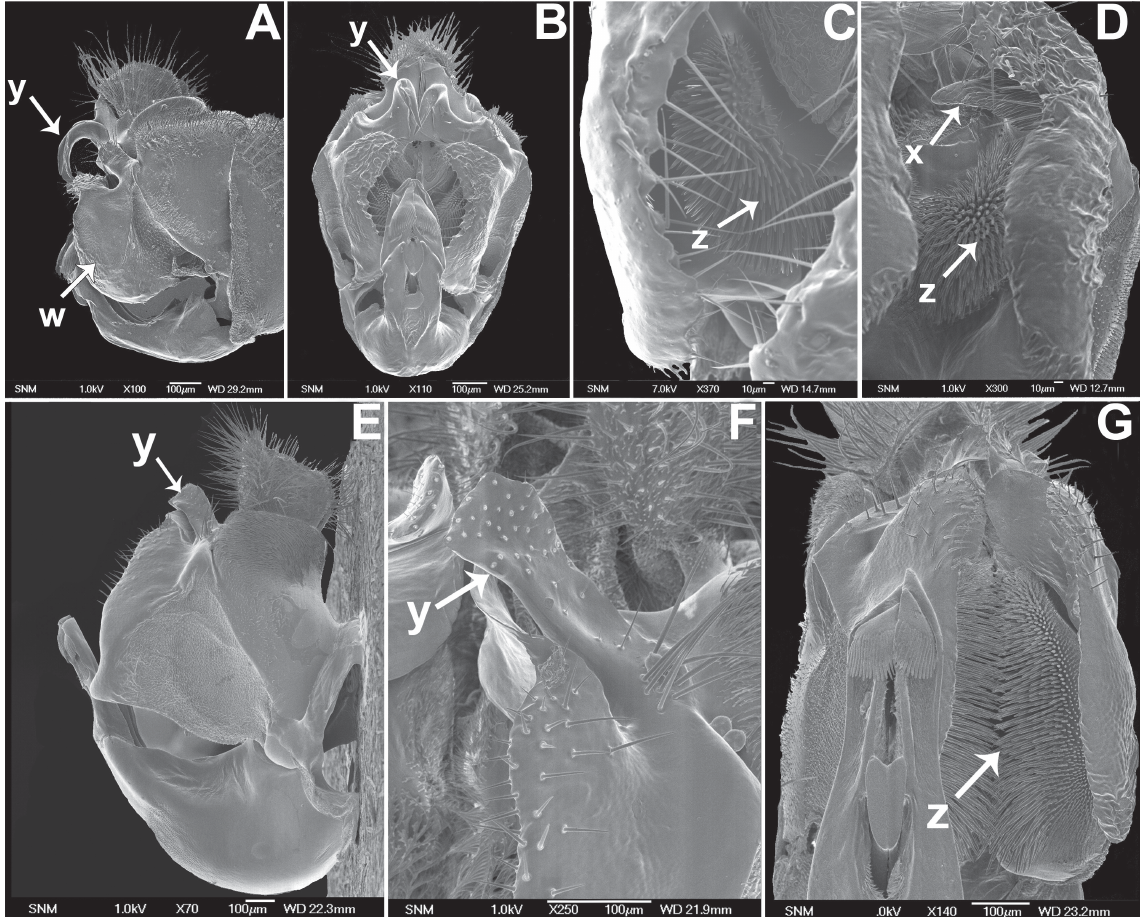
Fig. 13. Megatrigon spp., ♂ genitalia, lateral (a, F) and ventral (B–e, G) view (SeM). A – C . Megatrigon argenteus (Walker, 1852) comb. nov. D . M. magnicornis sp. nov. E . M. jacobi (Hervé-Bazin, 1913) comb. nov. F – G . Megatrigon sp . from the sexfasciatus group. Symbols: w = median surstyle; x = inner accessory lobe of median surstyle; y = posterior surstyle; z = subepandrial